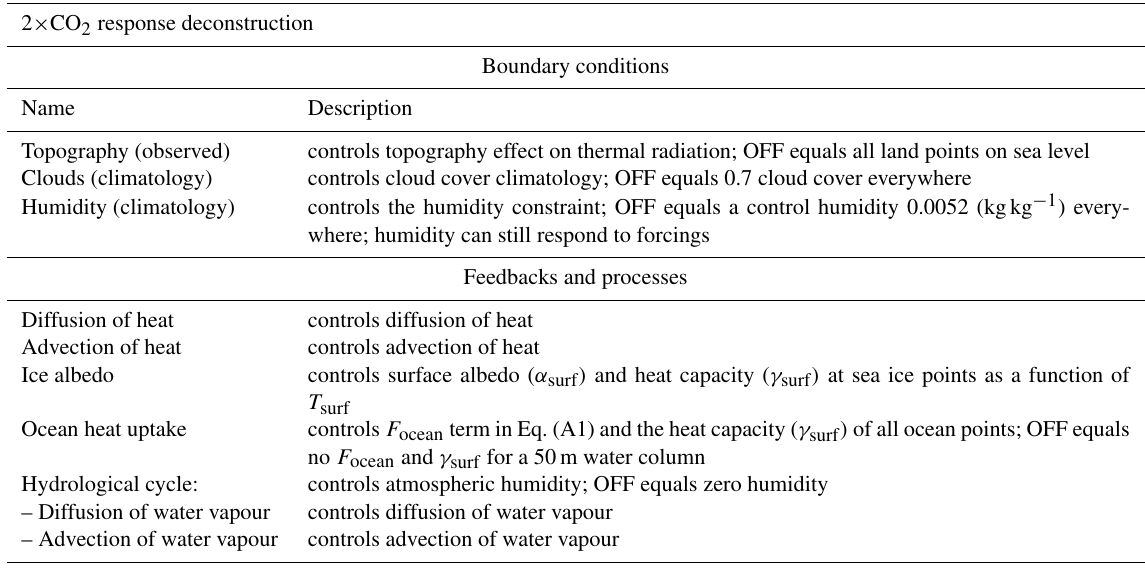
Table 2. Processes (switches) controlled in the sensitivity experiment for the 2 × CO 2 response deconstruction. Indentation in the left column indicates that process switches are dependent on the switches above being